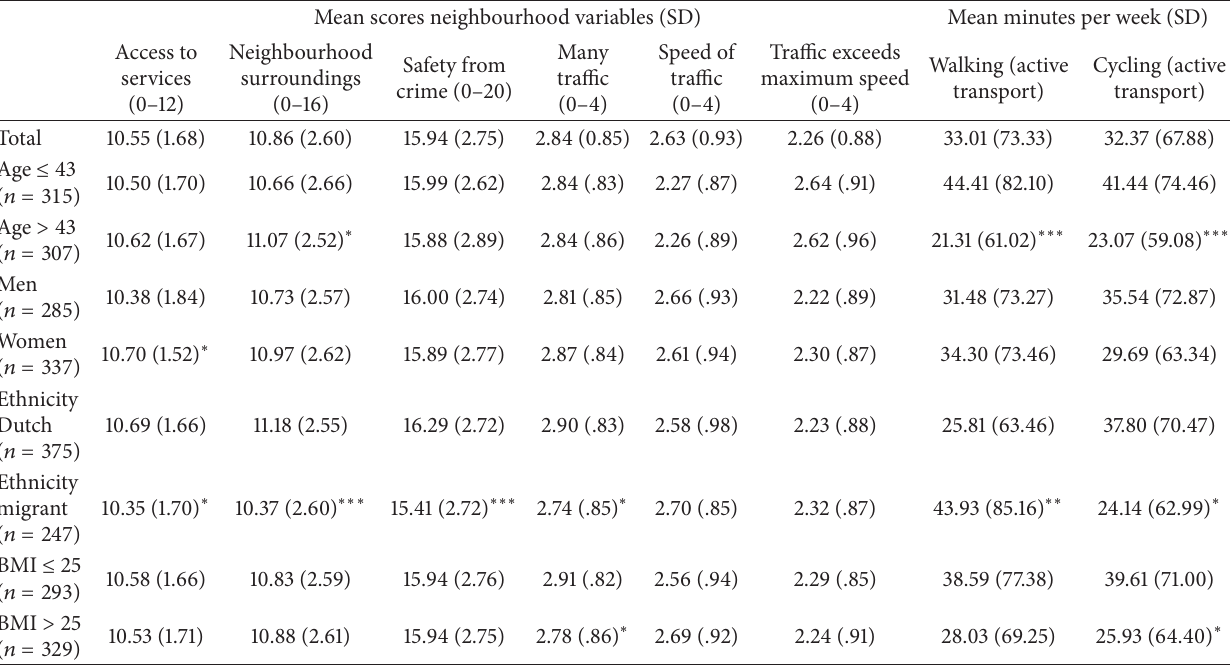
Table 2: Neighbourhood characteristics and minutes of active transport for